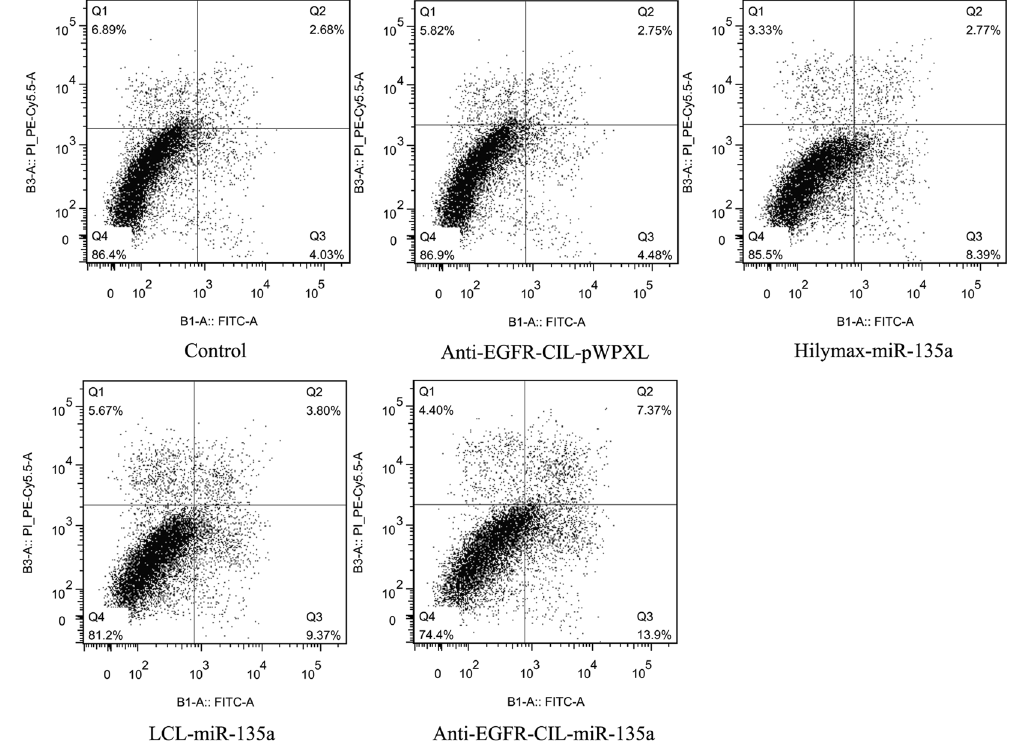
Figure 6. Annexin V/PI assays following Hilymax-miR-135a, LCL-miR-135a and Anti-EGFR-CIL-miR- 135a treatment of GBC-SD cells at 24 hours. Data (mean ± SD, n = 3) are representative of three independent experiments.